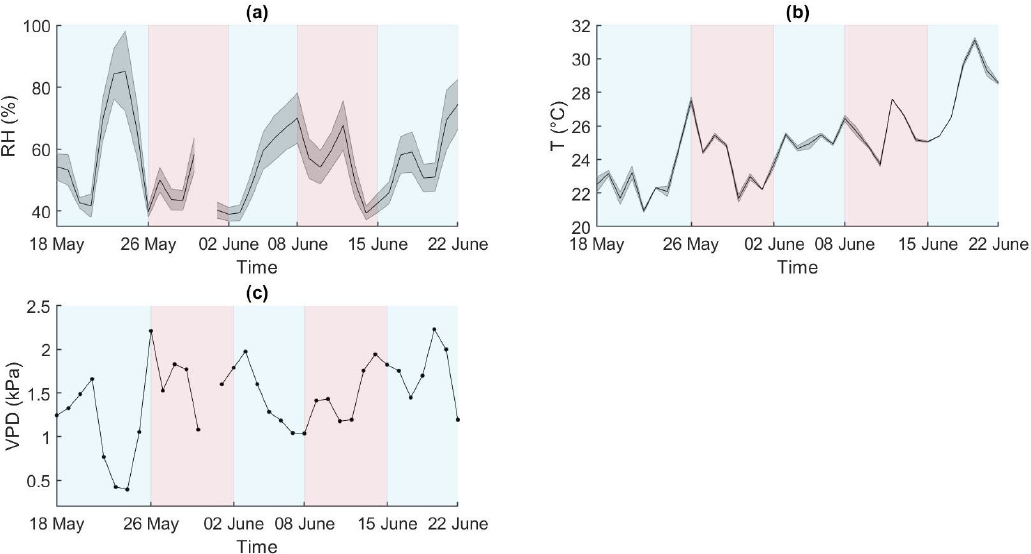
Figure 1. RH expressed in percentage ( a ), T expressed in ◦ C ( b ), and VPD expressed in Kilopascal ( c ) trends during the experiment. The red and blue areas represent the stress and recovery periods respectively. ( a , b ) report the mean of two sensors and the associated standard deviation. RH data were not recorded on day 31